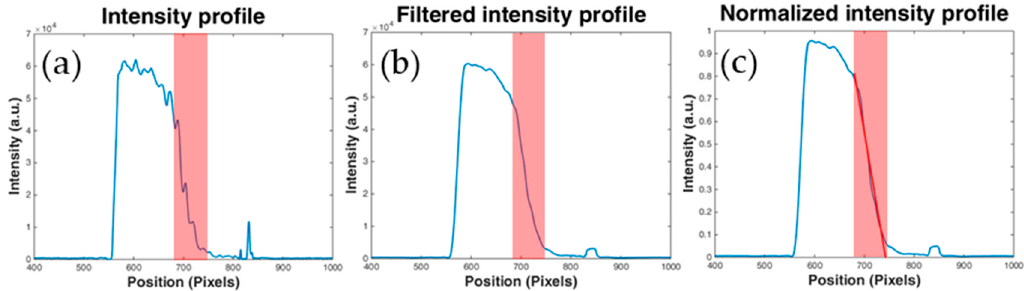
Figure 3 . Intensity profile of the flow behavior processed with MATLAB algorithm. The x-axis represents the position in the image [pixels], while the y-axis is the fluorescence intensity in arbitrary units (a.u.). The red region indicates the diffusion zone between the two liquids. ( a ) original, ( b ) processed by a low-pass filter, and ( c ) normalized intensity profile. The slope of the red line represents the diffusion behavior.